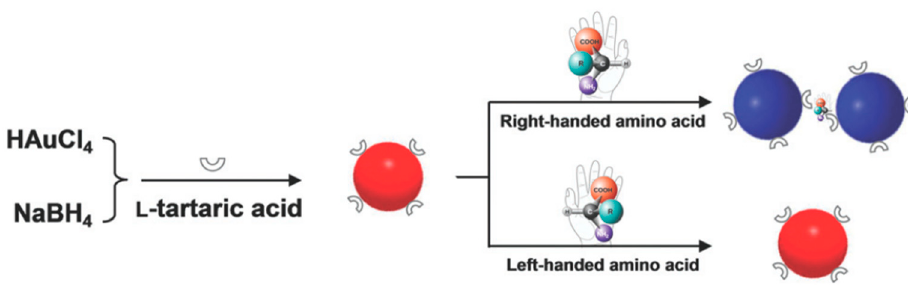
Figure 3. Schematic illustration of visual chiral recognition of right-handed and left-handed amino acid using L -tartaric acid-capped AuNPs as colorimetric probes. The figure and the caption have been adapted with permission from [56], Copyright © 2016 The Royal Society of Chemistry.